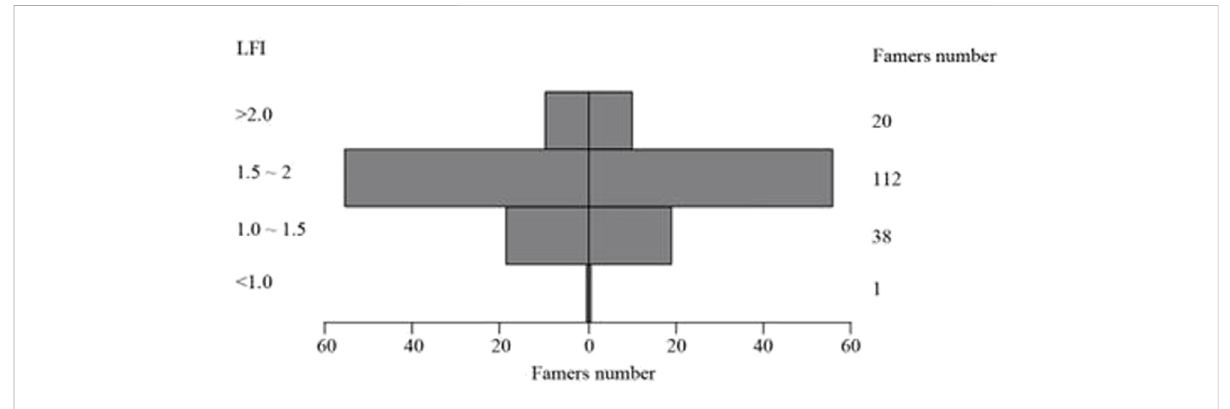
FIGURE 7 Correlation analysis on